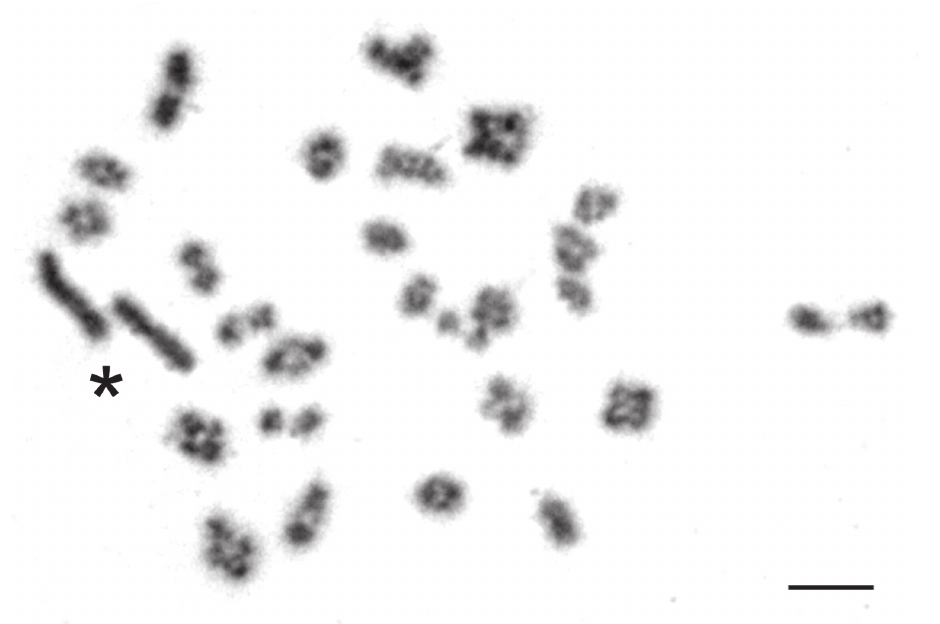
Figure 3. Meiotic spread with 26 autosomal bivalents and the characteristic asynaptic configuration of the sex chromosomes (star) from a male common vole of Olkhon Island (2 n =54). Bar=10